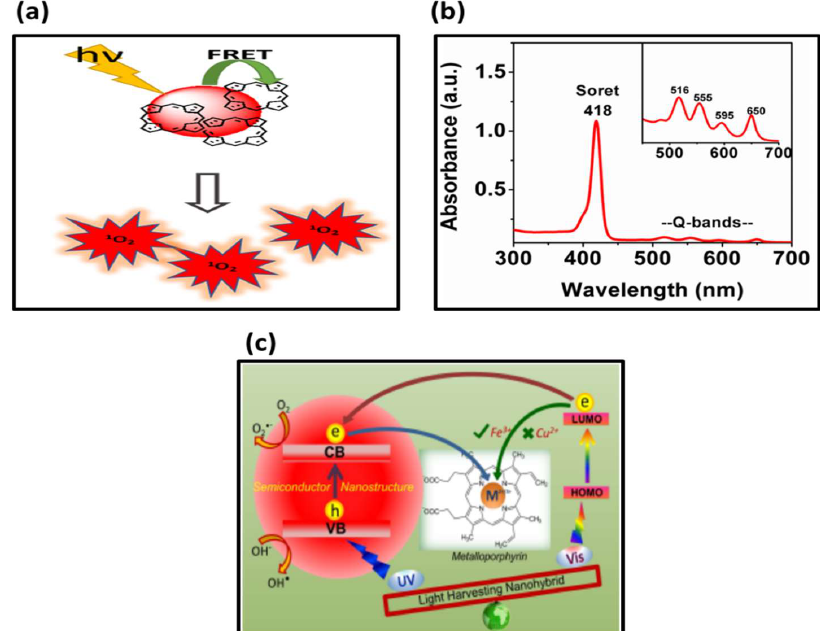
Figure 1. ( a ) Schematic diagram for generation of singlet oxygen [14]; ( b ) UV absorption spectra of free base porphyrin] [14]; ( c ) Metallated porphyrin functionalized with naphthalene-2-yl propenes (NPs) [15].